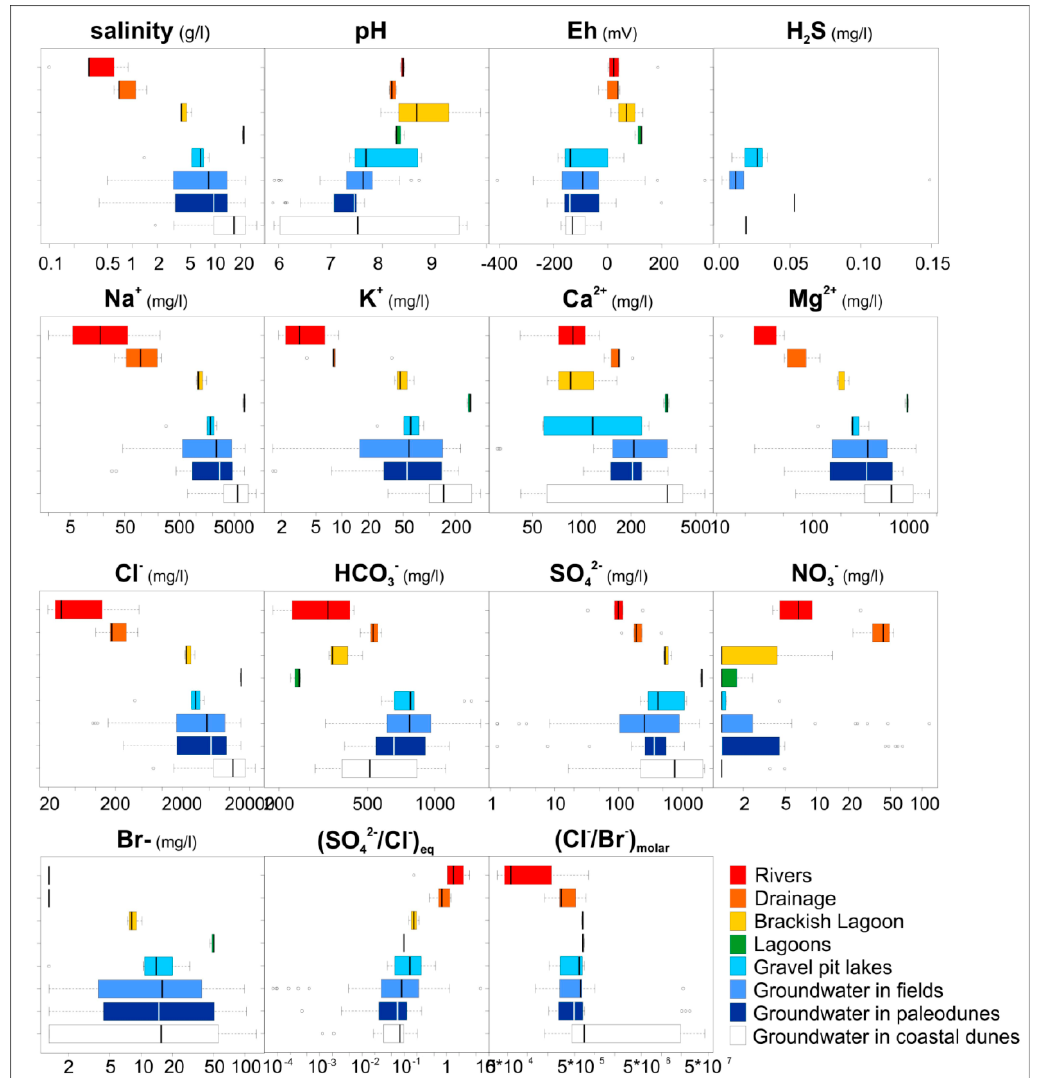
Figure 3. Box plot of major elements for the different environments. Concentrations are reported on a log scale and sea data refer to [66,67].